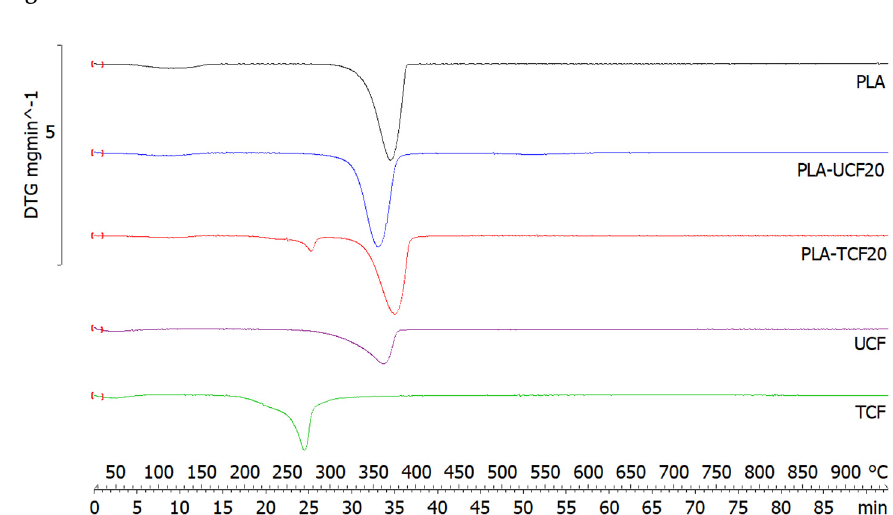
Figure 7. DTG curves of films and fibers with and without treatment.